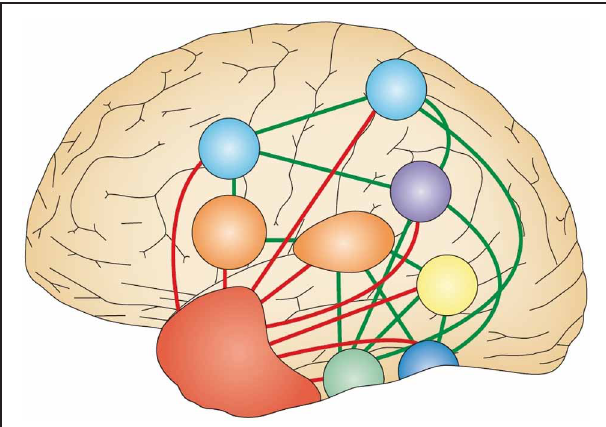
FIGURE 1 | The hub and spoke model of semantic processing. The various different modality-specific surface representations correspond to motion (yellow), colors (dark blue), shape (green), names (orange), actions (light blue) and task (purple), and are directly connected via green lines. These all connect (shown as red lines) to a shared, amodal “hub” (shown as a red area) in the anterior temporal lobes. At the hub stage, therefore, associations between different pairs of attributes (such as shape and name, shape and action, or shape and color) are all processed by a common set of neurons and synapses, regardless of the task. Adapted from Figure 1B of Patterson et al. (2007,